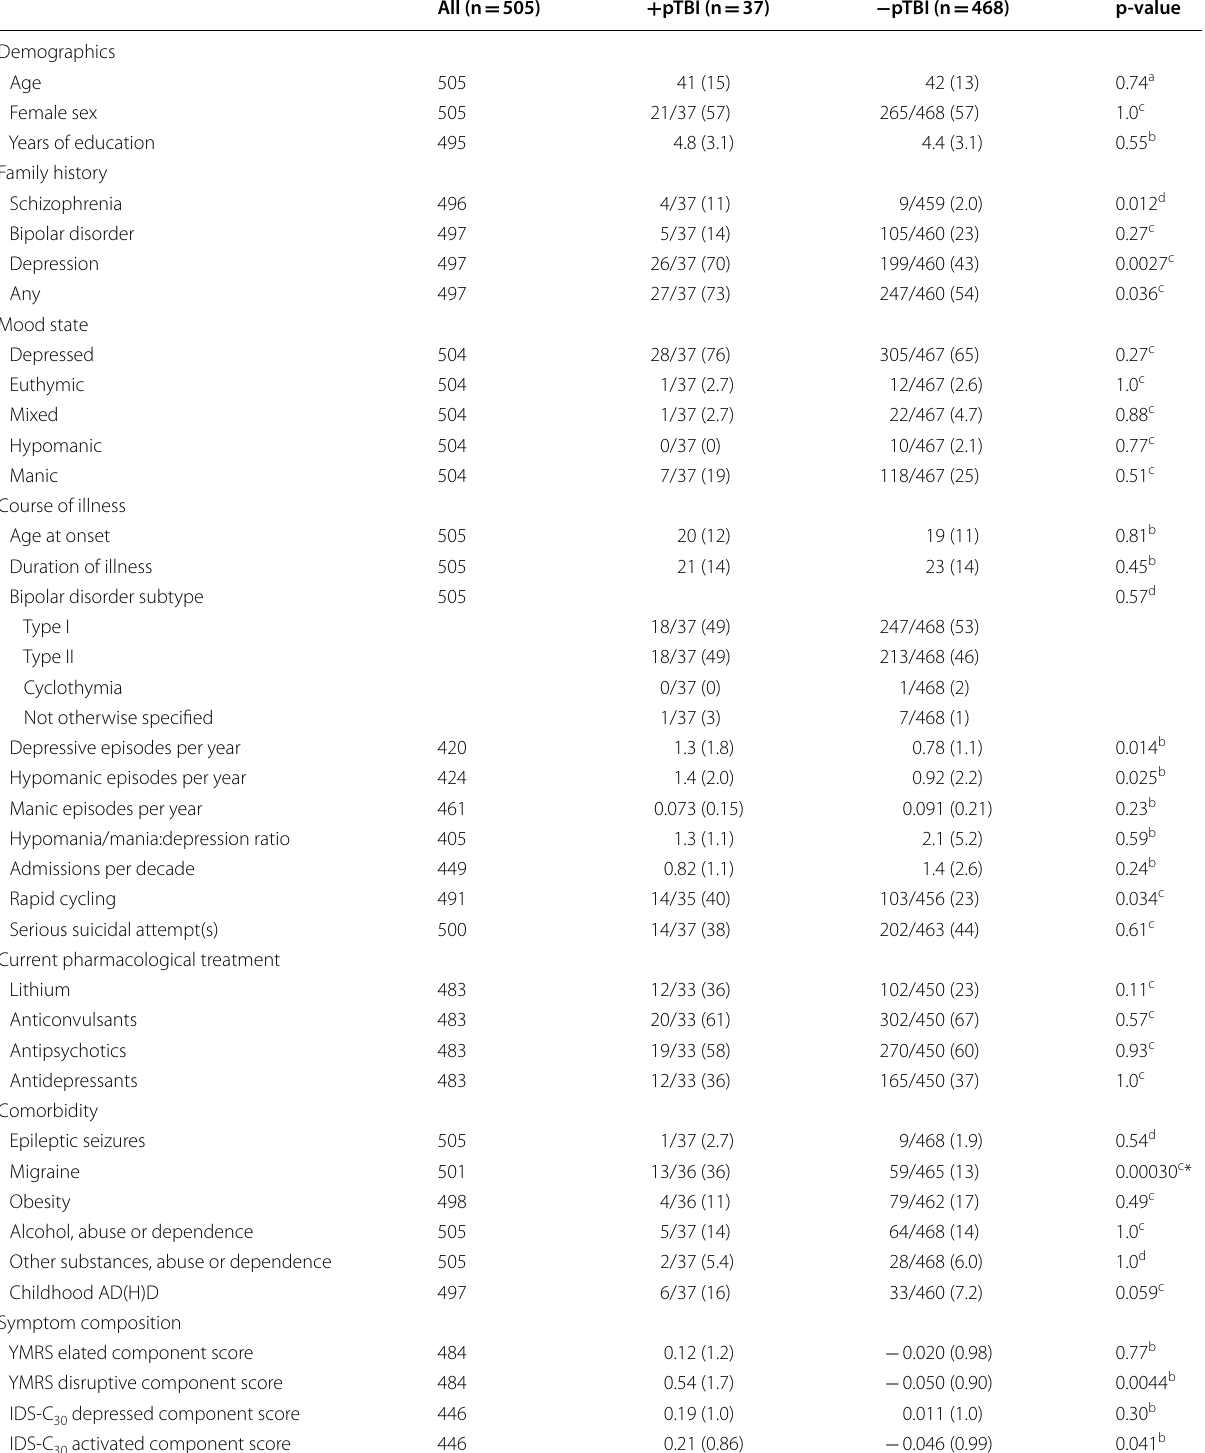
Table 3 Demographics, family history, and clinical characteristics in patients with and without premorbid